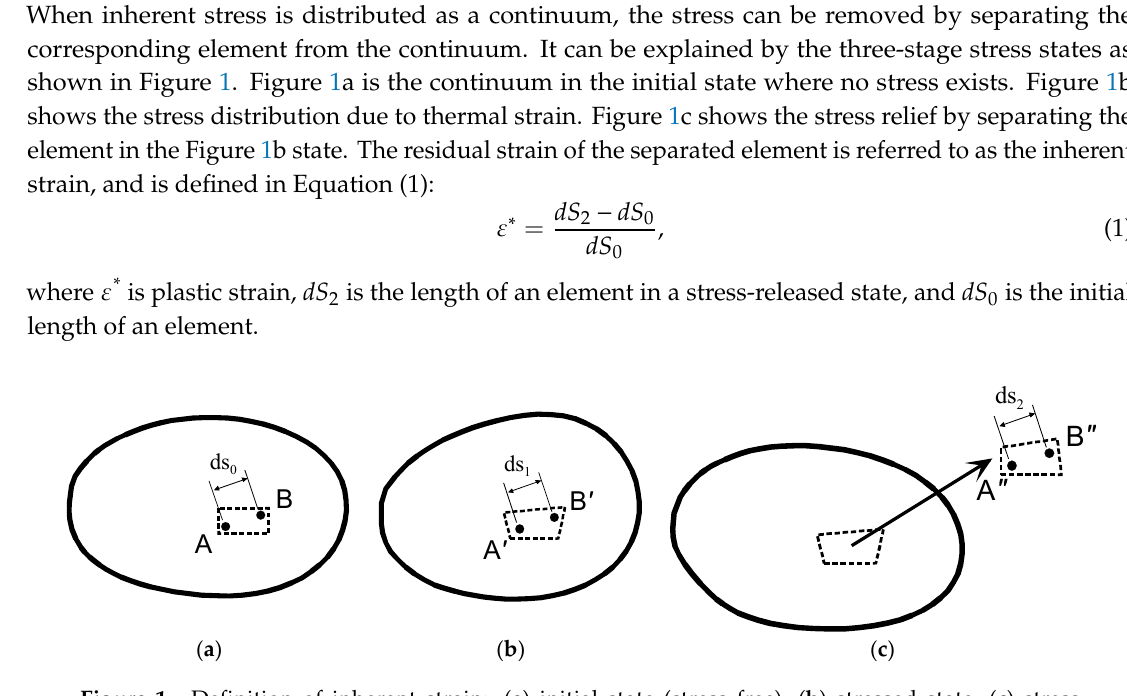
Figure 1. Definition of inherent strain: ( a ) initial state (stress free), ( b ) stressed state, ( c ) stress released state.